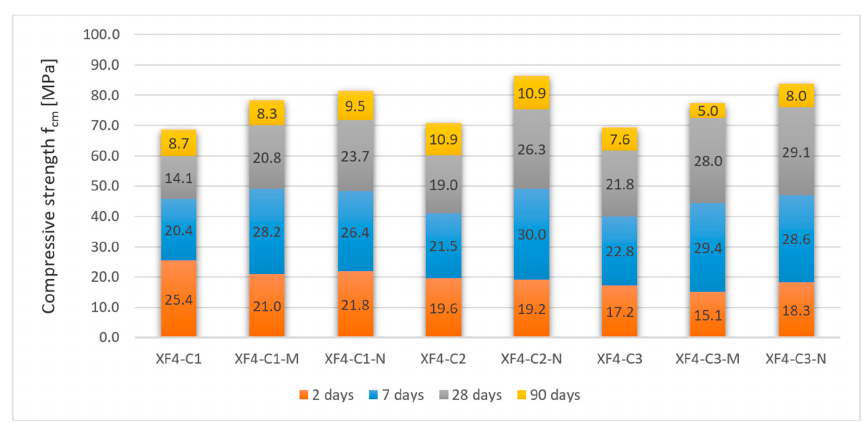
Figure 9. Compressive strength f cm —concretes XF4. Table 9. Properties of XF4 concretes with CO 2 emission level.